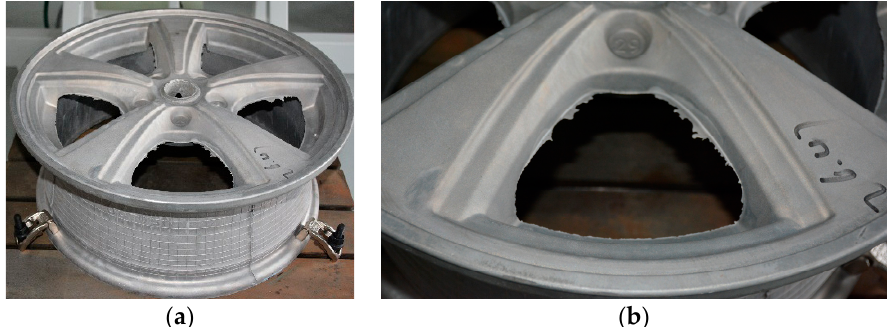
Figure 11. Casting blank of automobile hub: ( a ) overall appearance of automobile hub; ( b ) disc burrs of automobile hub.